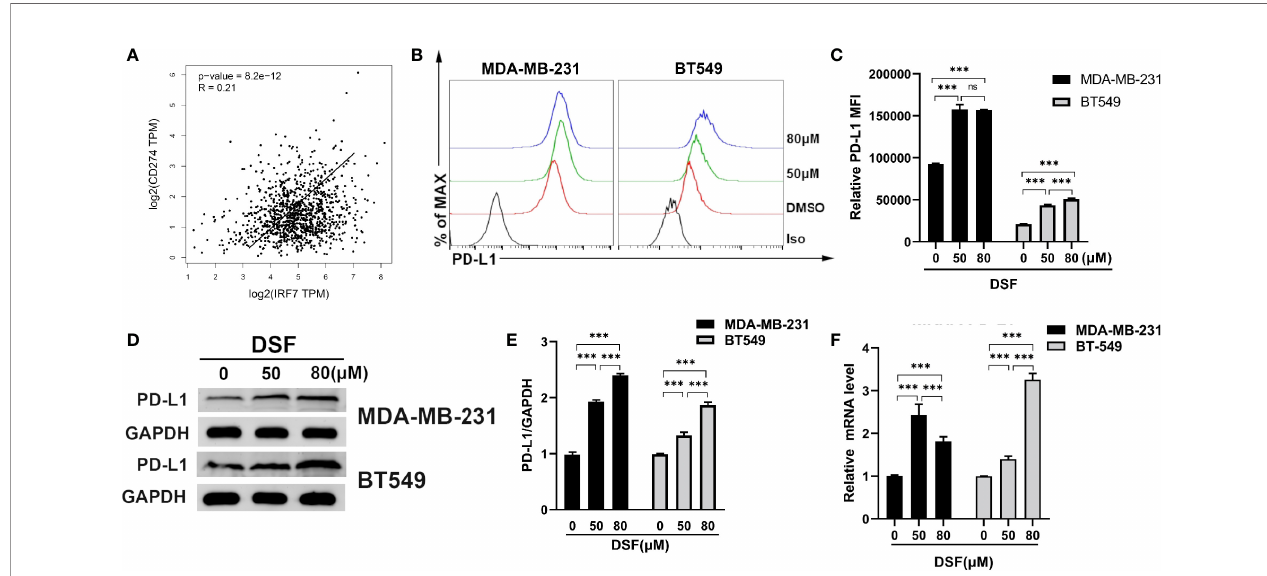
FIGURE 3 | DSF increases PD-L1 expression in vitro . (A) The positive relationship between the mRNA expression of PD-L1 and IRF-7 in breast cancer. (B) Flow cytometry result of surface level of PD-L1 on MDA-MB-231 cell and BT-549 cell treated with different doses of DSF for 48 h. (C) The quanti fi cation of relative mean fl uorescence intensity (MFI) of PD-L1 on MDA-MB-231 cell and BT-549 cell treated with different doses of DSF for 48 h. (D) PD-L1 protein expression after DSF treatment. MDA-MB-231 and BT- 549 cells were treated with different doses of DSF for 48 h, and PD-L1 protein levels were analyzed by Western blotting. (E) Quantitative analysis of PD-L1 expression after different doses of DSF for 48 h through ImageJ intensity measurements. (F) The relative mRNA expression levels of PD-L1 in human MDA-MB-231 cells and BT-549 cells treated with indicated concentration of DSF for 48 h. ***p < 0.001. ns, no statistic signi fi